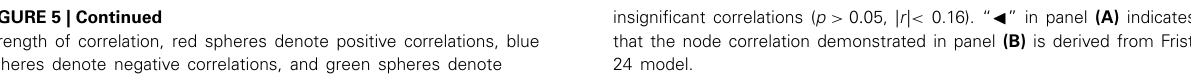
FIGURE 5 | Continued strength of correlation, red spheres denote positive correlations, blue spheres denote negative correlations, and green spheres denote 24 model.